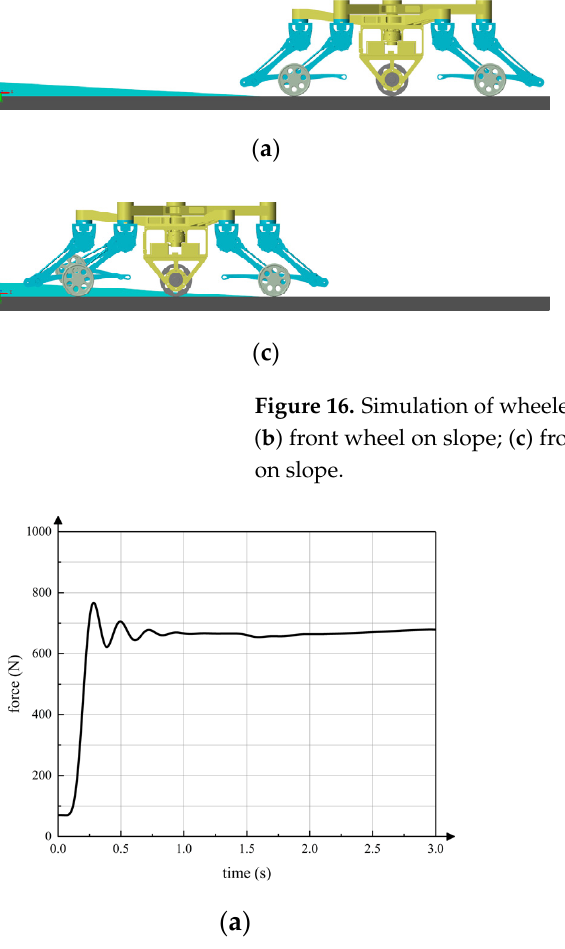
( d ) Figure 18. Simulation of wheeled motion (unilateral passive wheels and active wheel on slope). ( a ) no wheel on slope; ( b ) front wheel on slope; ( c ) front wheel and active wheel on slope; ( d ) Three wheels on slope. ( a )